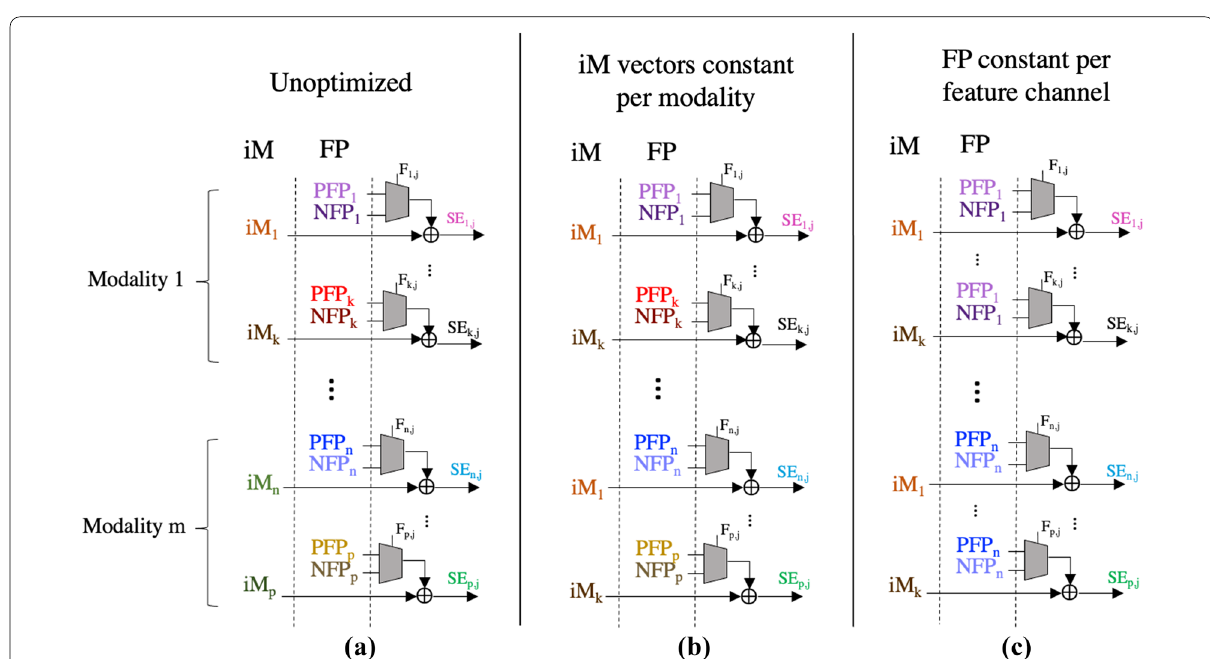
Fig. 4 iM and FP vectors used to map into HDS to generate unique SE vectors per channel for a ‘unoptimized’ with distinct iM and FP vectors for all channels, b ‘iM vectors constant per modality’ with the same iM vectors between different modalities, and c ‘FP constant per feature channel’ with the same FP vectors between channels of the same